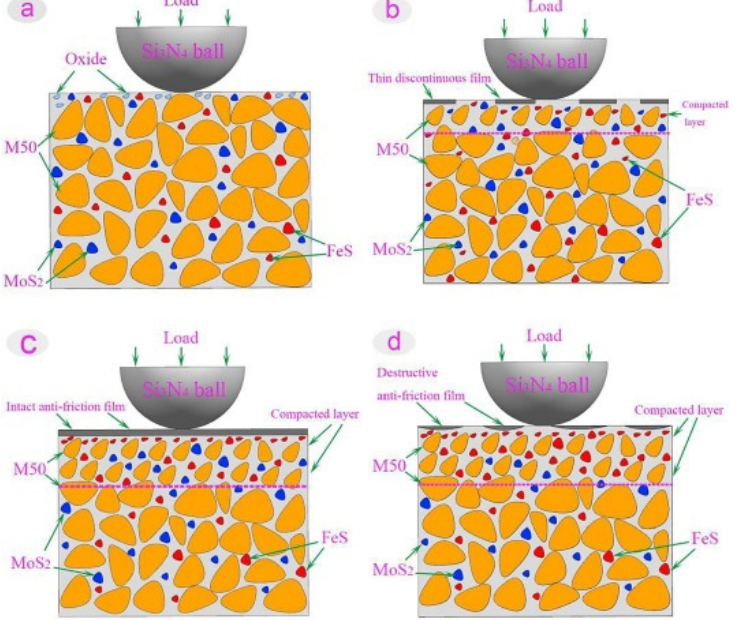
Figure 9. Wear mechanisms of M50 steel with 5 wt. % MoS 2 at ( a ) 150 °C, ( b ) 250 °C, ( c ) 350 °C, and ( d ) 450 °C. Reproduced with permission from [80]. Copyright, 2017.